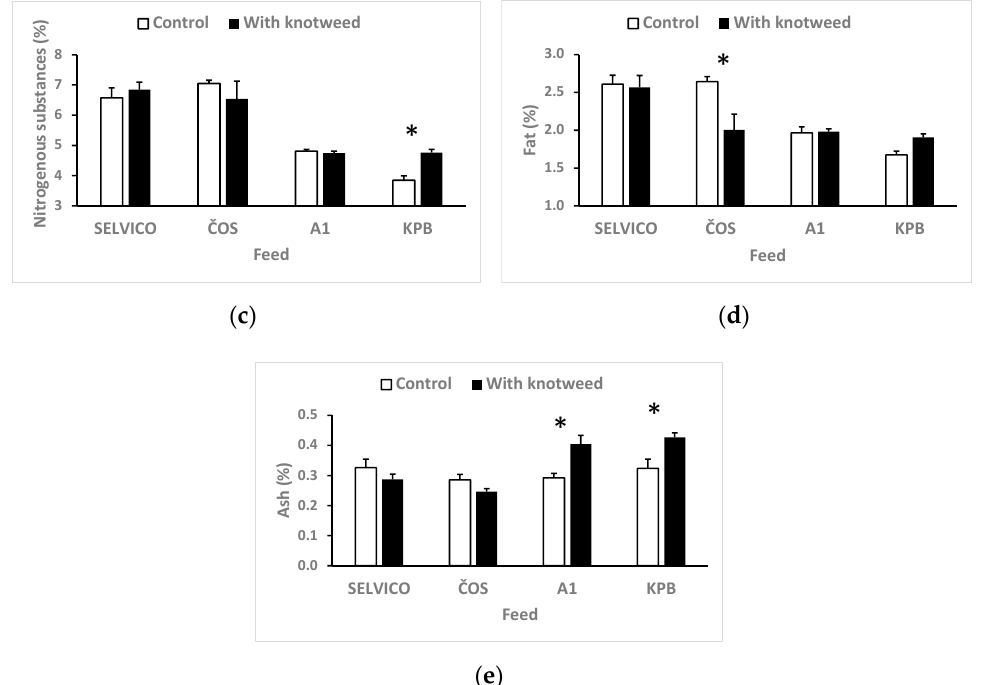
Figure 1. Comparison of the composition of faeces ( a —dry matter, b —fibre, c —nitrogenous substances, d —fat, e —ash) for individual fodder types between animals fed on fodder with knotweed and control groups fed on standard fodder. Means + SEM. Difference significant on p < 0.05 marked by an asterisk.